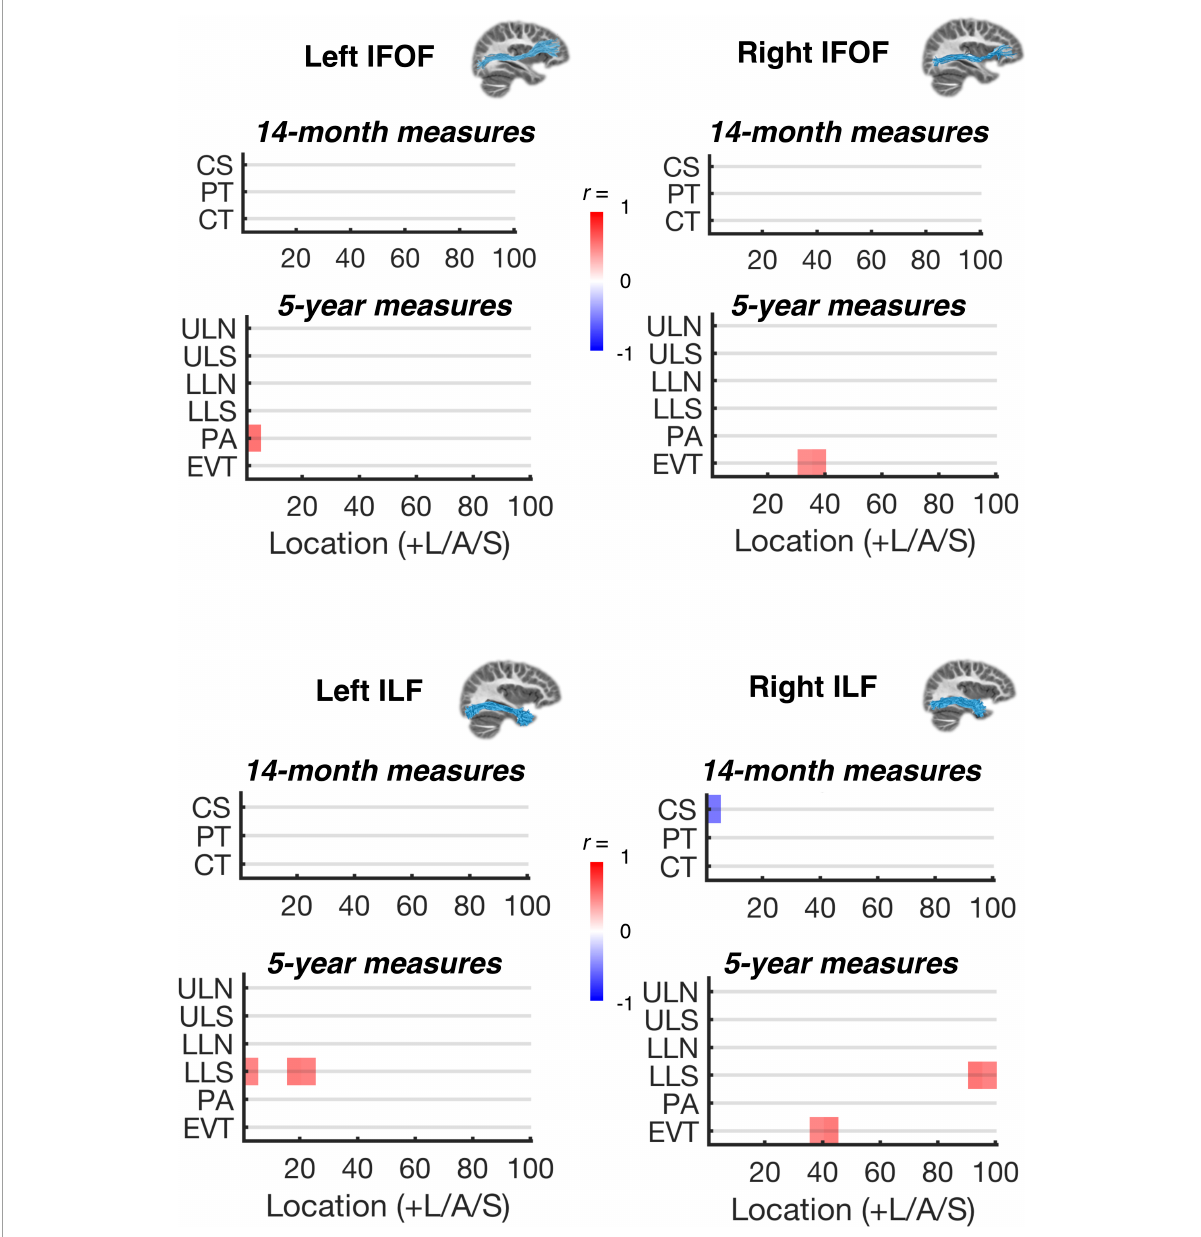
FIGURE3 Correlations between language measures and MPF estimates within ventral white matter pathways. Significant bivariate correlations ( p < 0.05, corrected for multiple comparisons along each tract; see section “Materials and methods”) are shown for each sampled white matter location within the left and right inferior-fronto-occipital and inferior longitudinal fasciculus (IFOF and ILF) and each behavioral variable: 14-month child speech (CS), parentese (PT), and conversational turns (CT); 5-year uppercase letter naming (ULN), uppercase letter sound knowledge (ULS), lowercase letter naming (LLN), lowercase letter sound knowledge (LLS), phonological awareness (PA), and expressive vocabulary test (EVT). Insets (top and middle right) show example tractography-based reconstructions for each of the white matter regions of